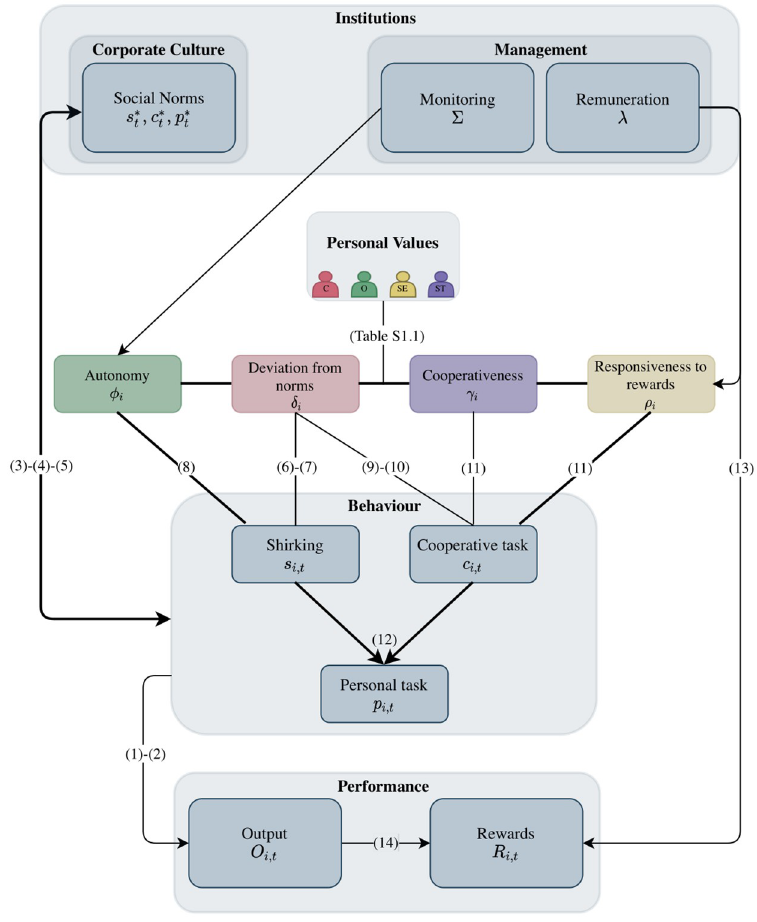
Fig 1. Model overview. The numbers in parenthesis are equation